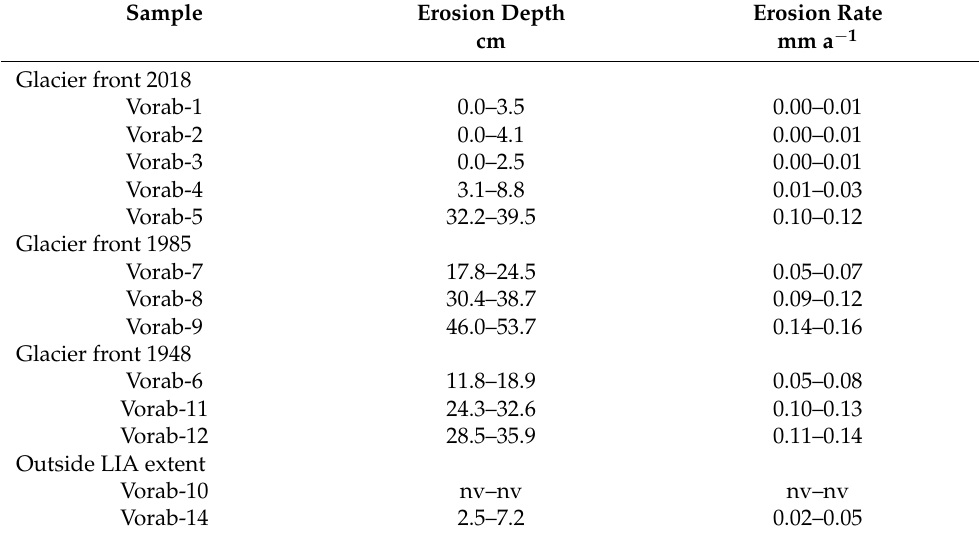
Figure 8. Modelled 36 Cl concentration-depth profile (light-blue) using the elemental and location data of Vorab-7. The solid line used the 200–100-200 cm snow scenario (see Figure 6 for details), the light blue band indicates the two extreme snow scenarios (0 cm snow and 200 cm snow). The AMS- measured concentration with its uncertainty is shown as vertical line in dark blue. The intersection of the two curves indicates the thickness of rock that had to be removed by the glacier to reach measured concentration (Table 1). The dark grey band highlights the erosion depth range (Table 3) with the intermediate snow scenario, the light grey indicates the minimal erosion depth when considering the 200 cm snow scenario and the maximal erosion depth with the zero snow scenario. By dividing this erosion depth by the total time of glacier coverage results in the average glacial erosion rates, given in parentheses. Table 3. Determined glacial erosion depths and rates (sample locations in Figure